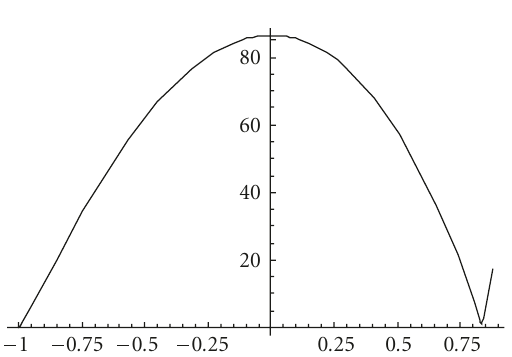
Figure 2.3. ( ρ 0 (cid:8) − 0 . 77075, ξ (cid:8) 0 . 3).